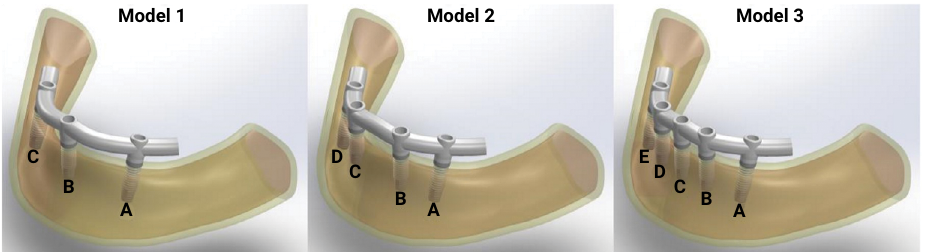
Figure 1. Three-dimensional computer models of three full-arch prosthesis evaluated, varying from 3 to 5